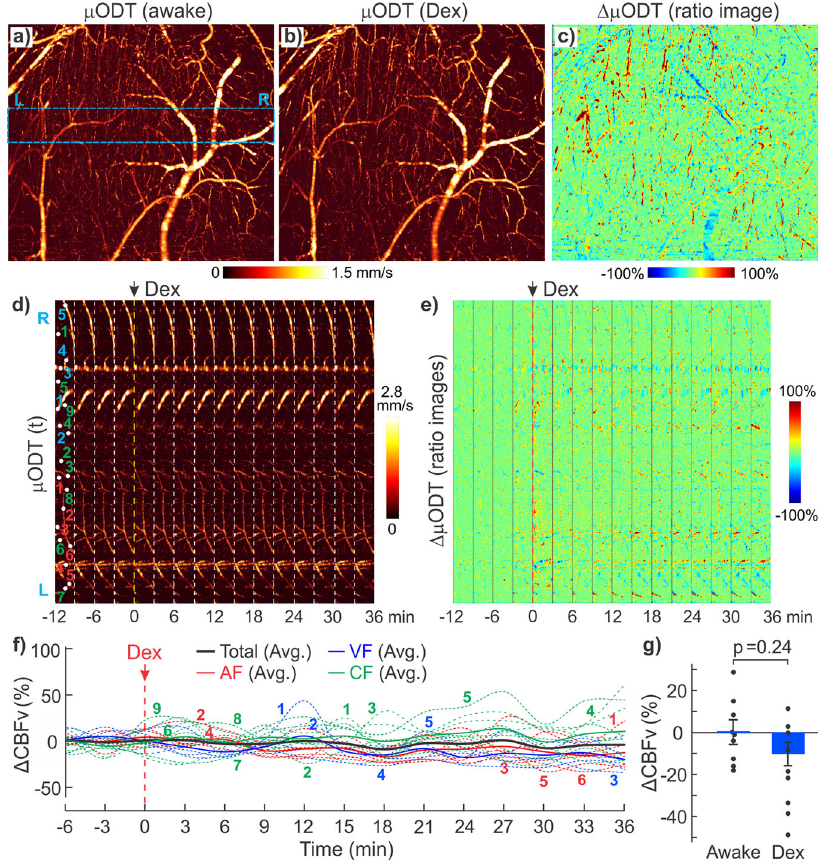
Fig. 6 3D μ ODT images of mouse sensorimotor cortex in awake vs Dex-anesthetized states. a , b Raw μ ODT images of awake vs Dex states and their ratio image ( c , image size: 2.3 × 2 × 1.2 mm 3 ); d , e time-lapse images μ ODT(t) and ratio changes Δμ ODT from awake to Dex anesthesia (image size: 2.3 × 0.3 × 1.2 mm 3 ); f Dex-induced CBFv changes. AF: arterial fl ow, VF: venular fl ow, CF: capillary fl ow; g comparison of mean Δ CBFv between awake state ( t : − 8 – 0 min) and Dex anesthesia ( t : 20 – 30 min) across animals ( p = 0.24, m = 8RoIs/animal, n =